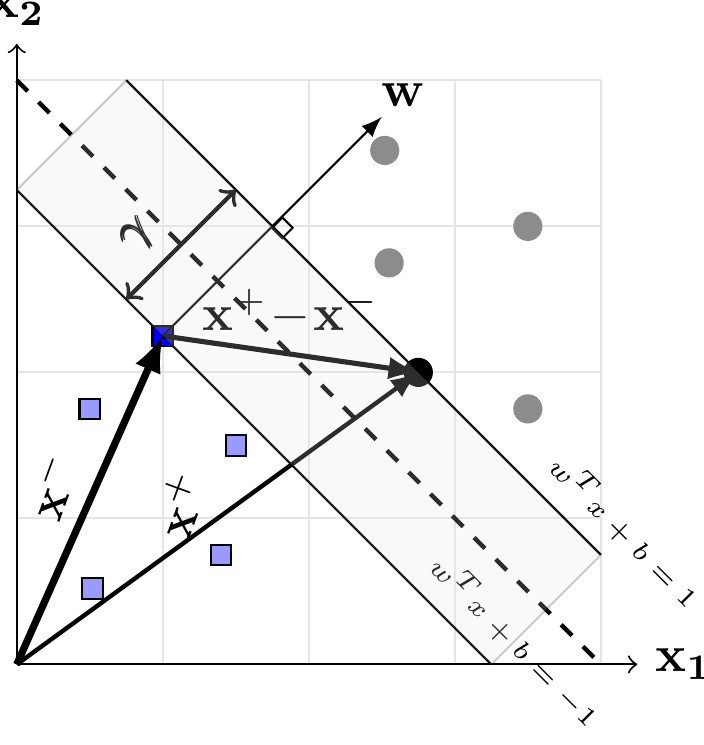
Figure 1. Two-dimensional hyperplane (dashed line) in the SVM, with support vectors x + and x − , belong to both